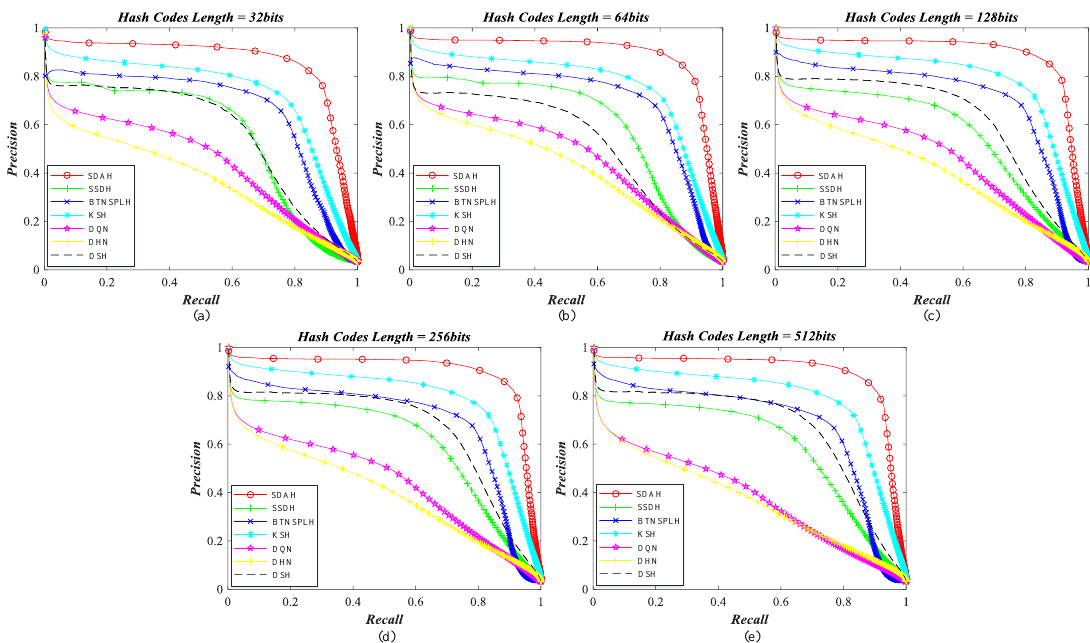
Figure 10. Retrieval precision–recall curve of different hashing methods counted on AID archive: ( a ) The length of hash codes is 32 bits; ( b ) the length of hash codes is 64 bits; ( c ) the length of hash codes is 128 bits; ( d ) the length of hash codes is 256 bits; and ( e ) the length of hash codes is 512 bits.